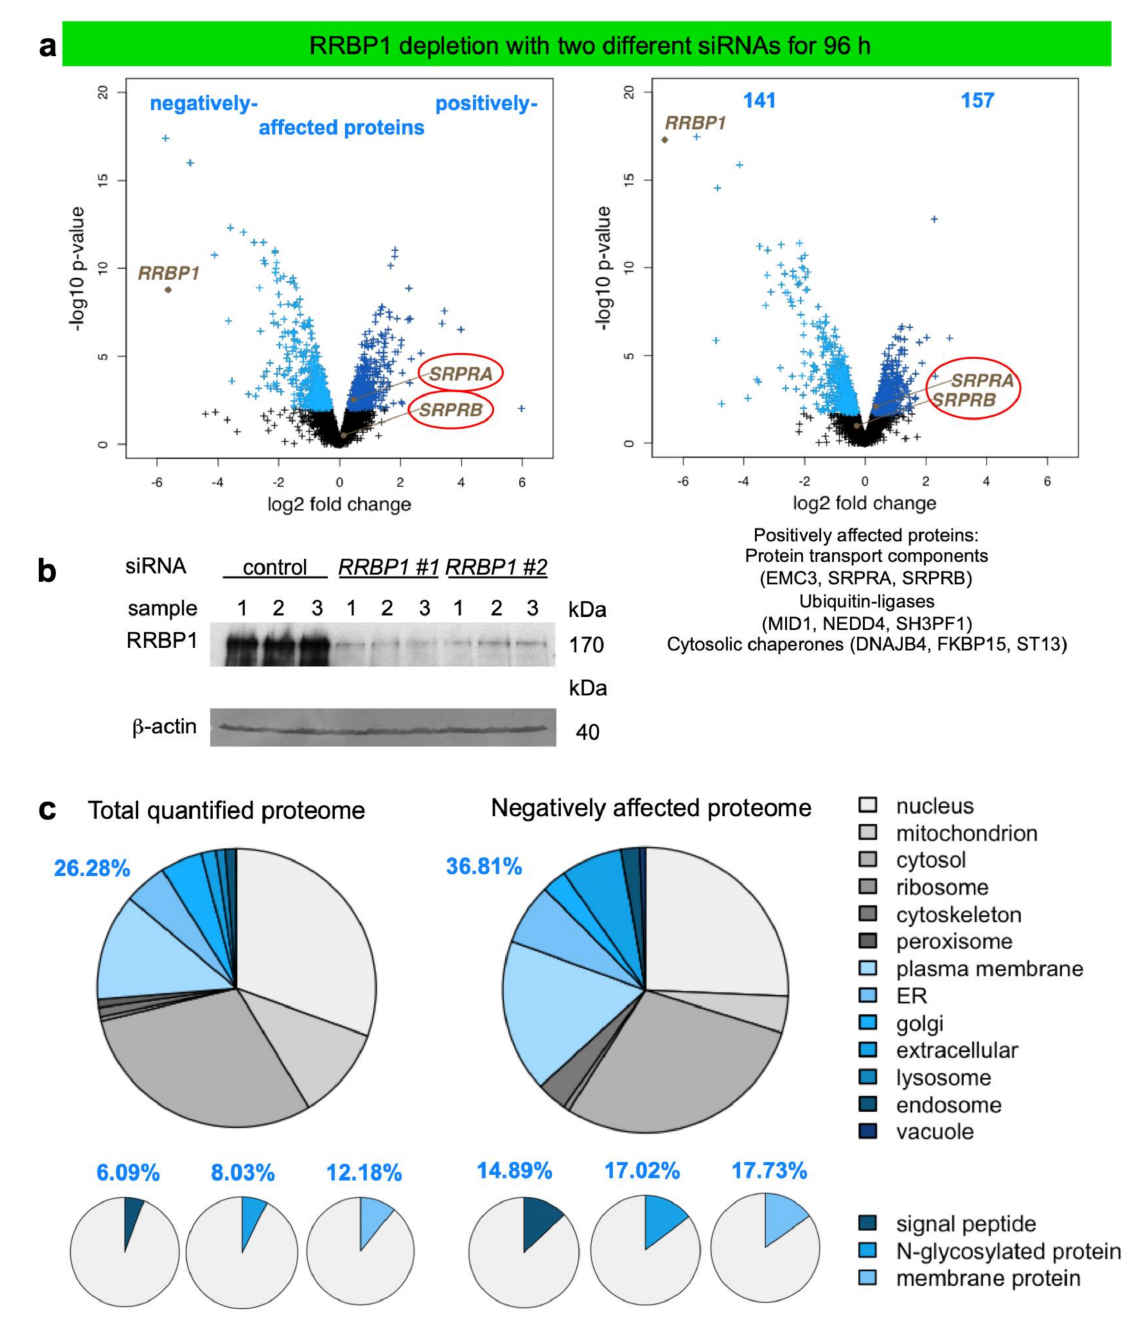
Figure 5. Volcano plots and GO enrichment after RRBP1 depletion. ( a ) Differentially affected proteins were characterized by the mean difference of their intensities plotted against the respective permutation false discovery rate-adjusted p -values in volcano plots. The results for a single targeting siRNA are shown in each panel. RRBP1 and the subunits of the SRP receptor are highlighted in the plots. In addition, the numbers of proteins, which were negatively or positively affected by both targeting siRNAs, are given in the right panel; the full set of relevant positively affected proteins are given below the right plot. ( b ) Knock-down efficiencies were evaluated by western blot. Molecular mass values are indicated in kilodaltons (KDa). Only the area of interest of the blot is shown, the original images are shown in Supplementary Materials. ( c ) Classification of RRBP1 clients was based on GO enrichment factors where the results from the complete set of quantified proteins in the left panel are compared with the negatively affected proteome. Protein annotations of signal peptides, membrane location, and N-glycosylation in humans were extracted from UniProtKB, and used to determine the enrichment of GO annotations among the negatively affected